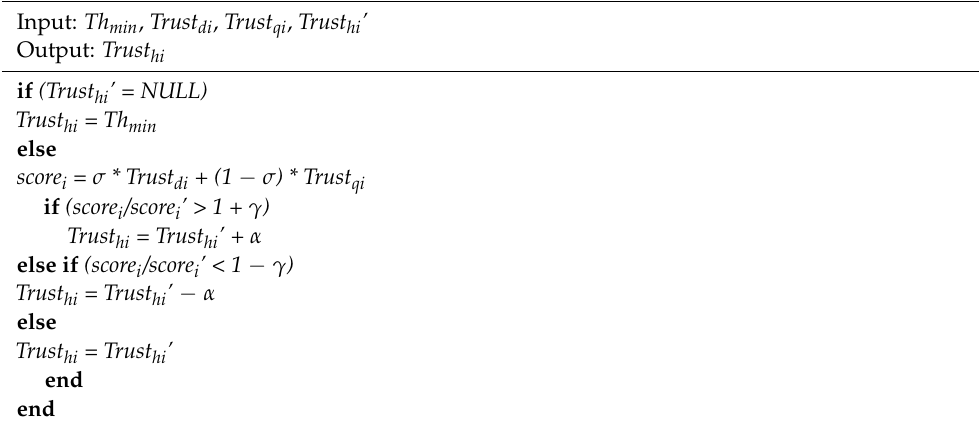
Algorithm 1: Trust value algorithm for node history